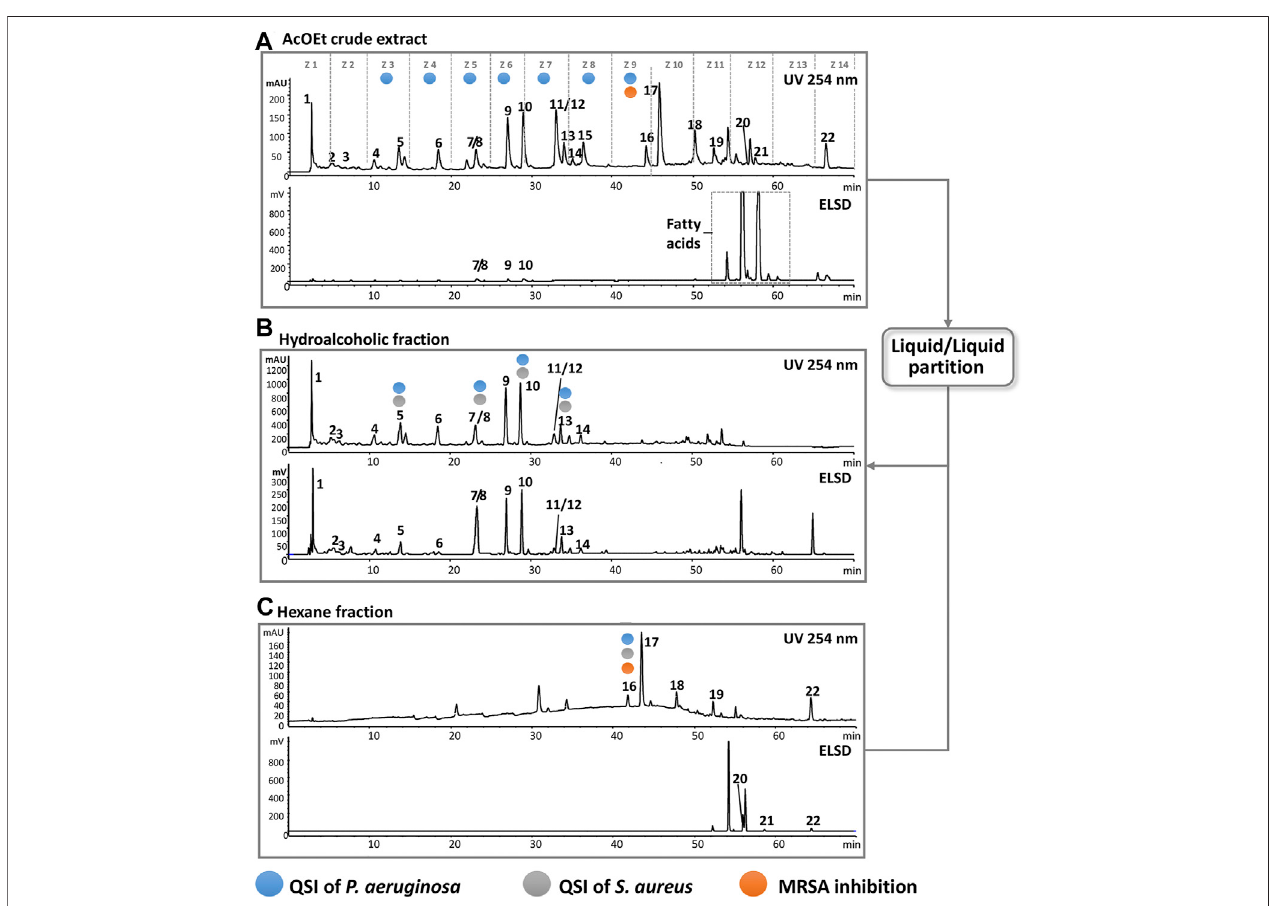
FIGURE6| HPLC-DAD-ELSDanalysishighlightingtheeffectoftheextractenrichmentandthelocationofvariousbioactivitiesmonitoring. (A) Chromatogramofthe crude extract; dashed lines represent the 14 chromatographic zones. Highlighted zones represent the part of the chromatogram for possible bioactivity. The square in theELSDhighlightsthepresenceoffattyacids. (B) Chromatogramofthehydroalcoholicpart. (C) Chromatogramofthehexane.Compoundsthatpossessbioactivityare annotated by colored circles, and the process demonstrates that they can be precisely localized after